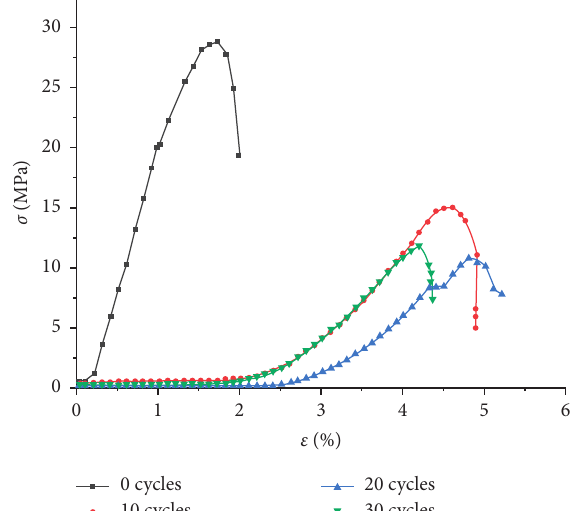
Figure 7: Typical stress-strain curves of samples with different freeze-thaw cycles.